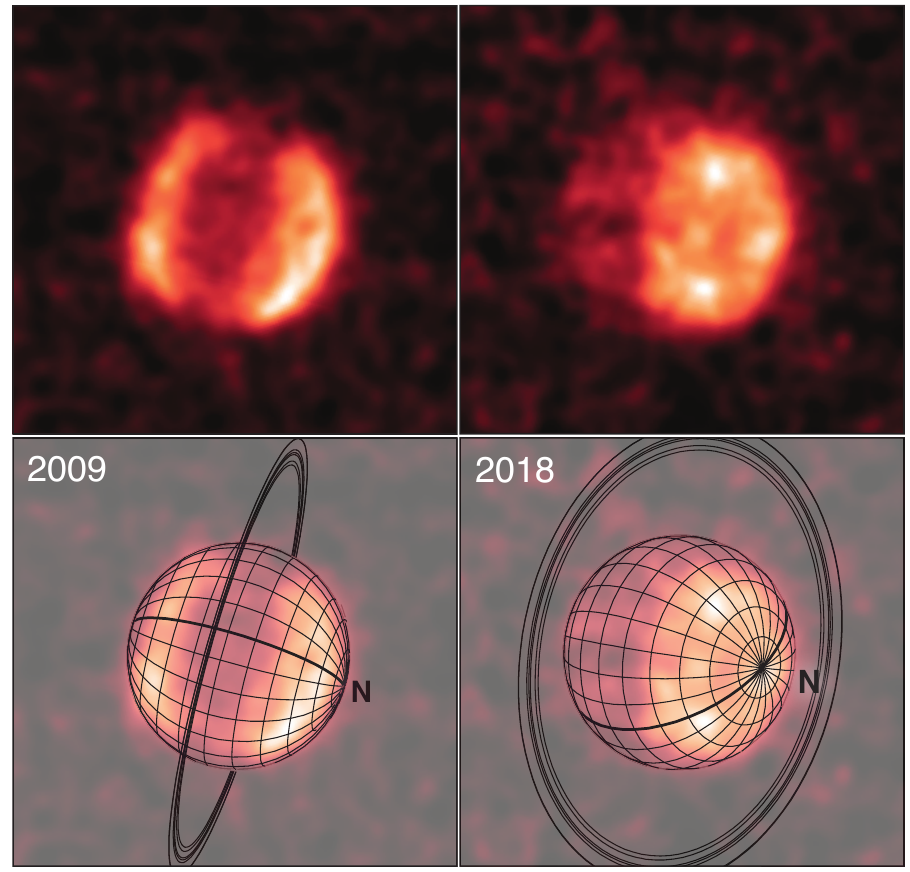
Figure 14. Uranus’ stratosphere at 13 µ m, as seen from VLT-VISIR in 2009 ( left ) and 2018 ( right ). Differences in the geometry of the observations are illustrated in the bottom panels. The cause and precise spatial distribution of the enhanced radiance at high latitudes is unclear